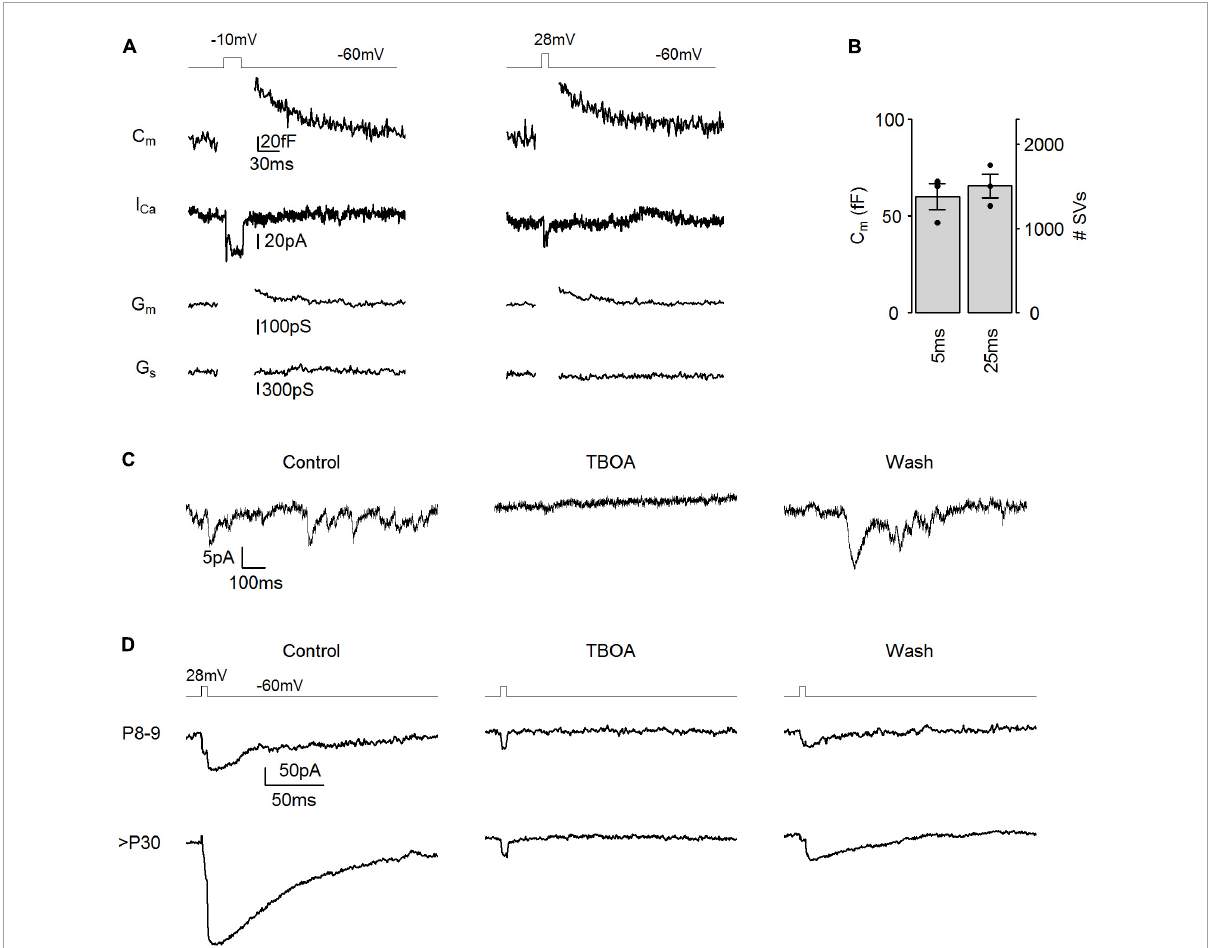
FIGURE2 I AGlu events as a reliable measure of SV release. (A) Representative membrane capacitance (C m ) and Ca 2 + current (I Ca ) traces evoked by step depolarizations ( left panel : –60 to –10 mV, 25 ms, right panel : –60 to 28 mV, 5 ms). G m : membrane conductance, G s : series conductance. (B) Membrane capacitance change in response to step depolarizations ( p = 0.195, n = 3 cells, paired t -test). (C) Representative tonic I AGlu events (V h = –40 mV) in control conditions (Control), during puff application of 350 µ M TBOA (TBOA), and following TBOA application (wash). (D) Representative I AGlu events in response to a step depolarization (–60 to 28 mV, 5 ms) in control conditions (control), during puff application of 350 µ M TBOA (TBOA), and following TBOA application